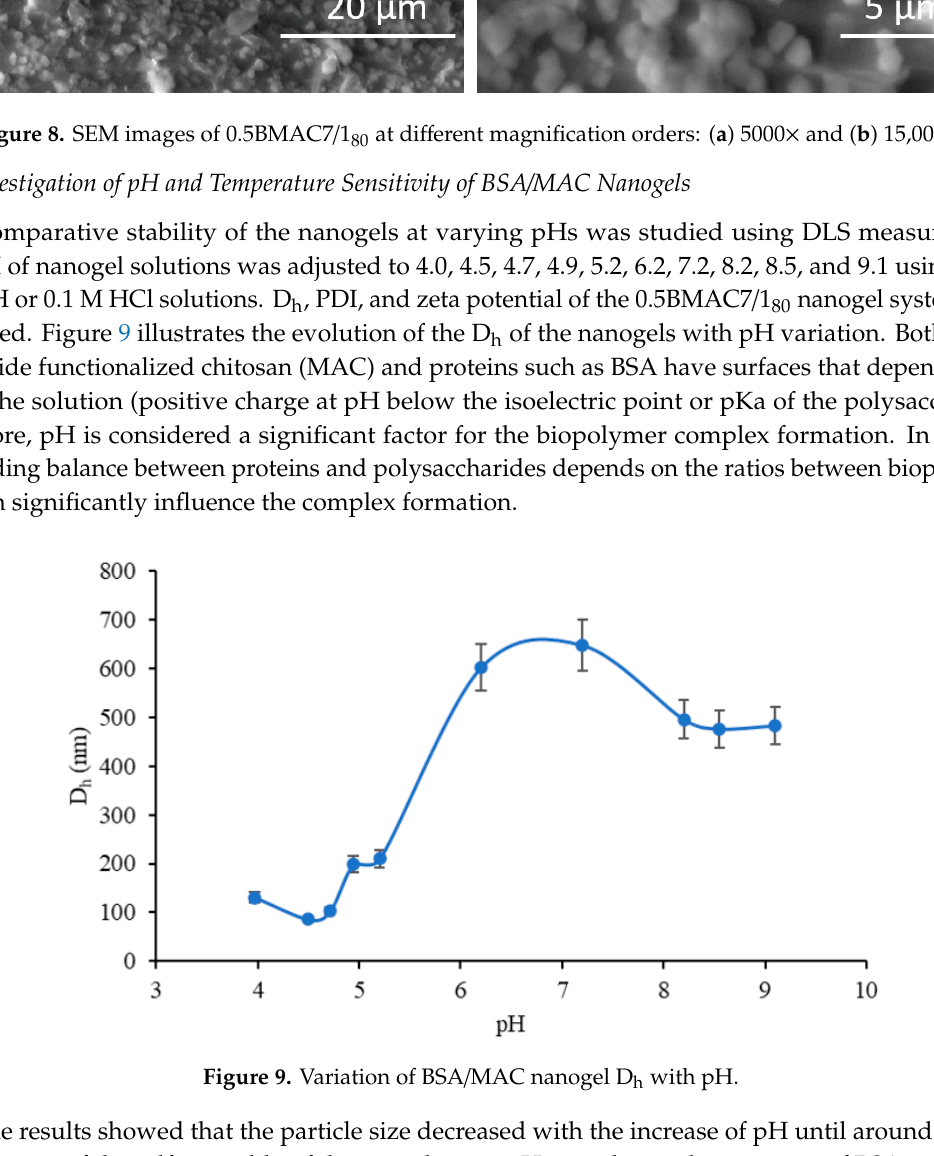
Figure 8. SEM images of 0.5BMAC7 / 1 80 at di ff erent magnification orders: ( a ) 5000 × and ( b ) 15,000 × .